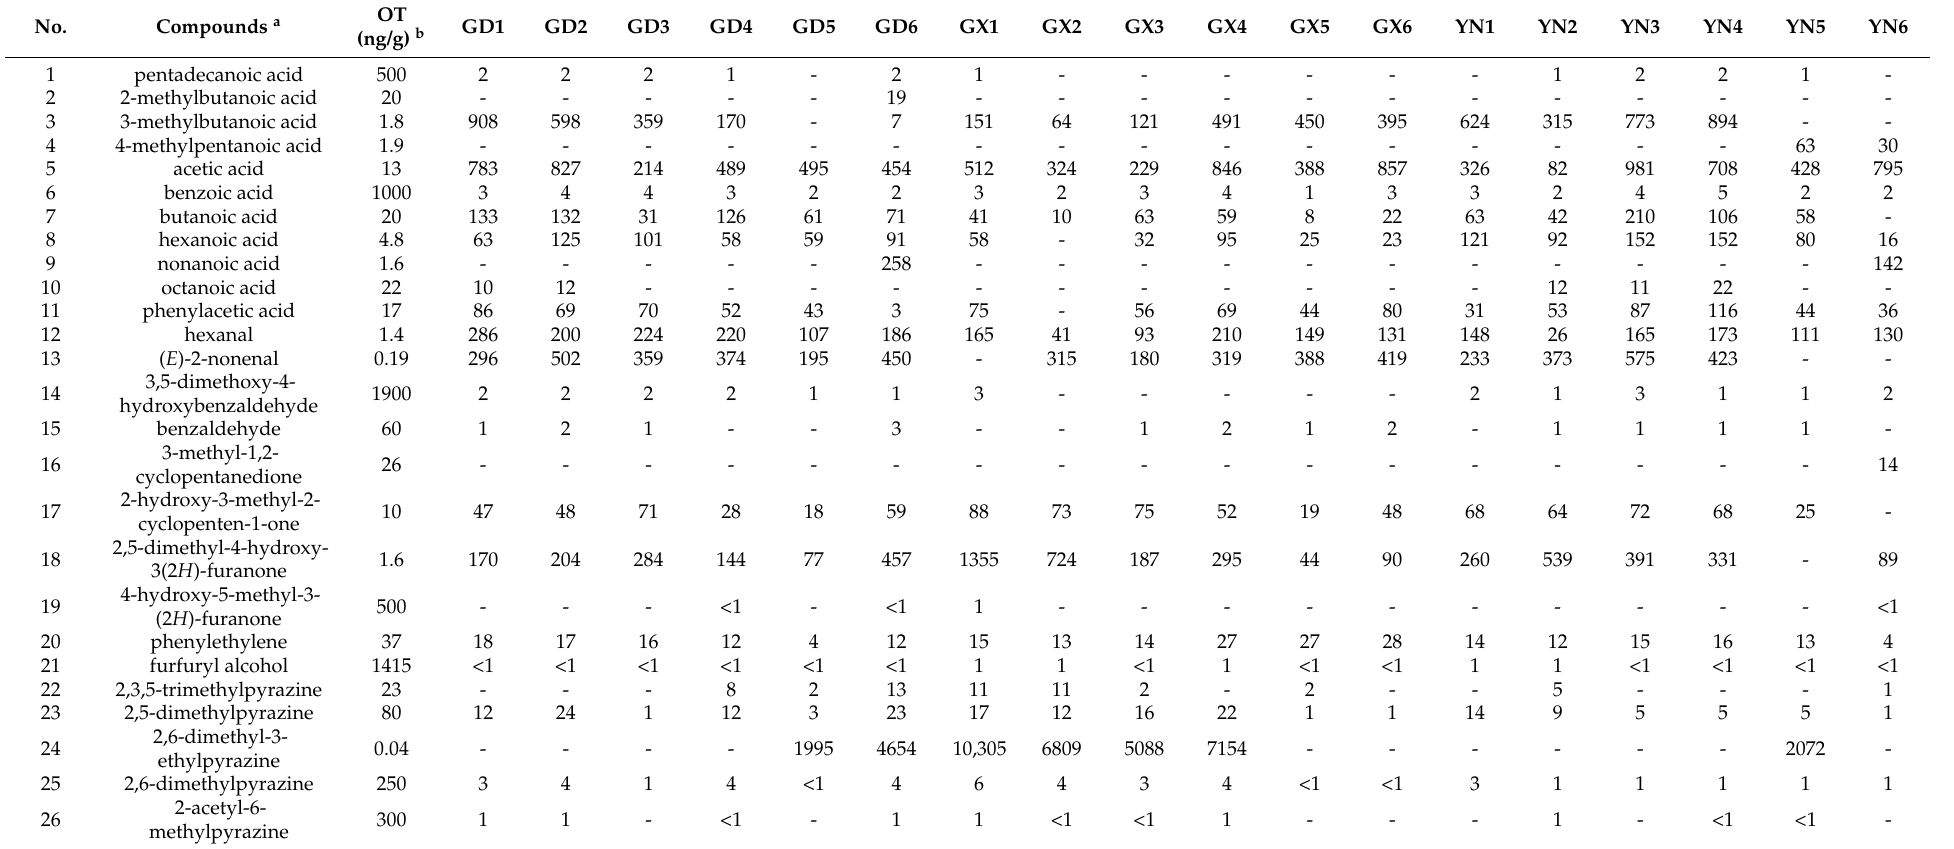
Table 2. OAV of key odor compounds in brown